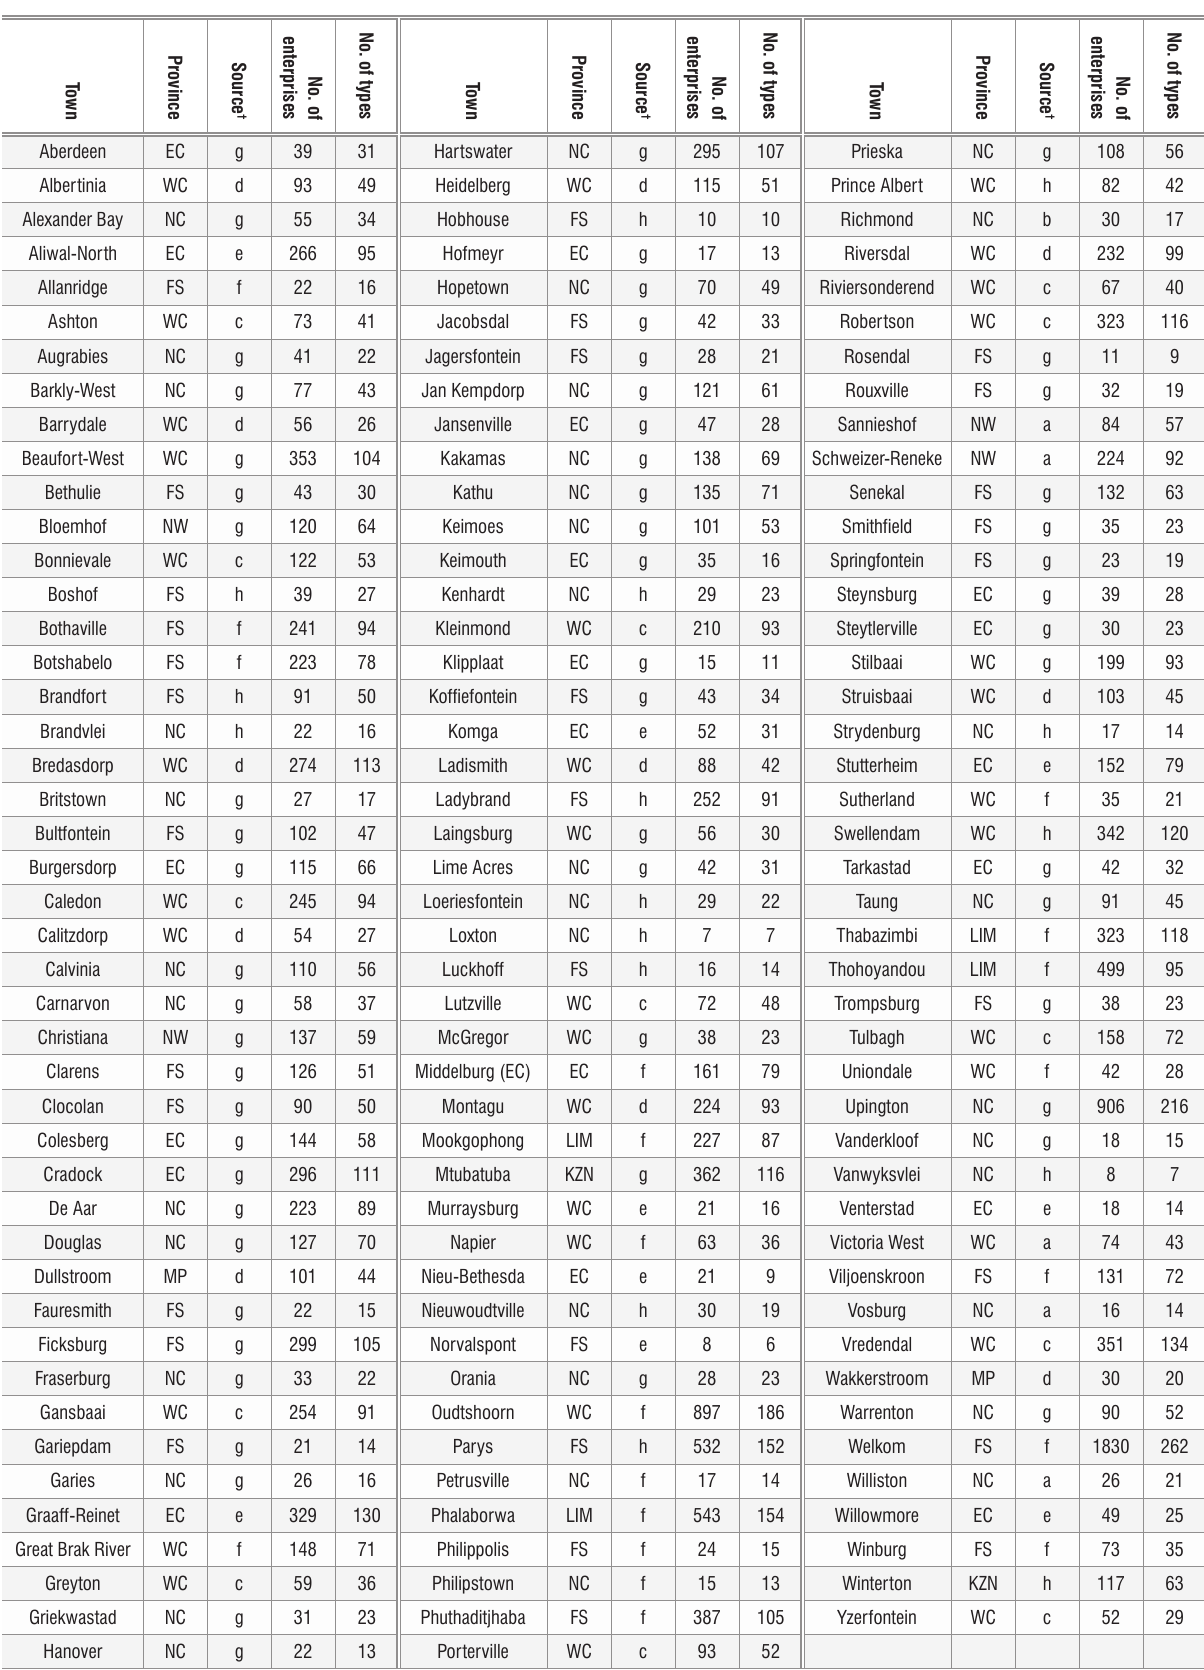
Table 1: South African towns used in this